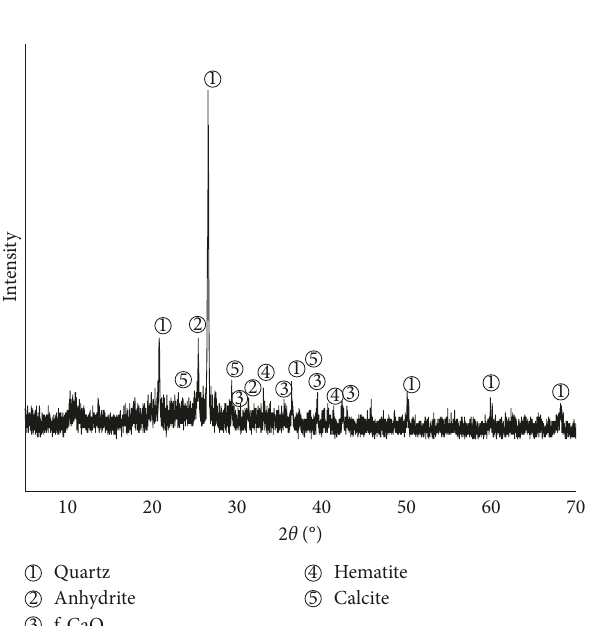
Figure 1: XRD patterns of CFBC desulfurized